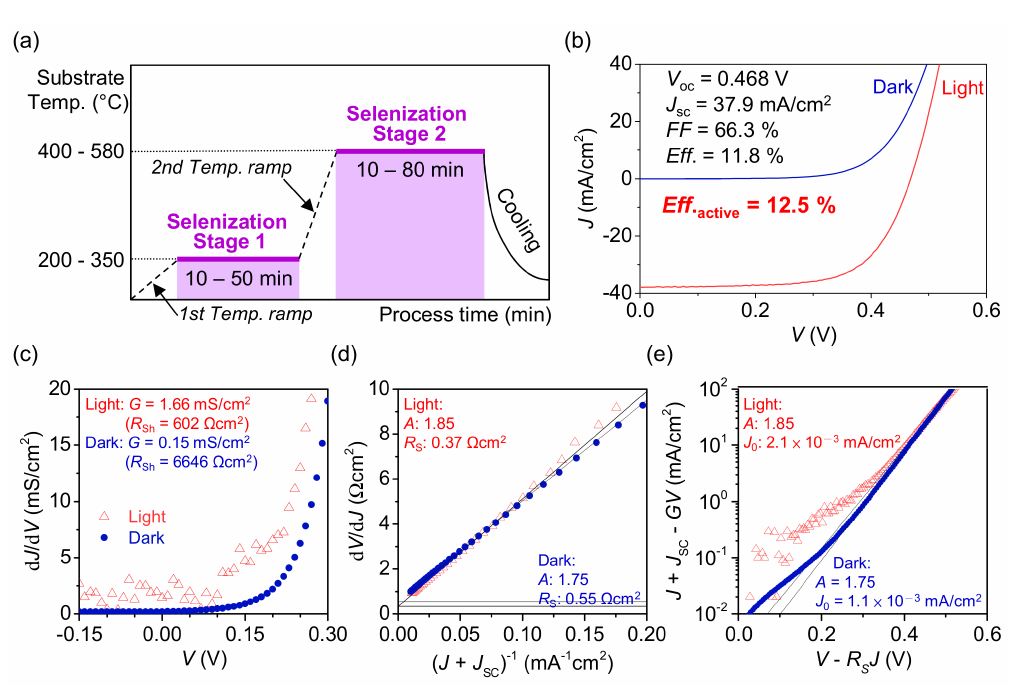
Figure 1. ( a ) Temperature profile of metal precursors during selenization for two-step process, ( b ) J - V characteristics of a CIGS solar cell prepared by the two-step process, ( c ) the derivative of d J /d V for the determination of the shunt characteristics, ( d ) the derivative of d V /d J in forward bias with fit used to determine the series resistance and the diode ideality factor, and ( e ) ln( J + J SC − GV ) with fit used to determine the reverse saturation current density and the diode ideality factor. ( Eff . and Eff . active denote the total-area efficiency and active-area efficiency,